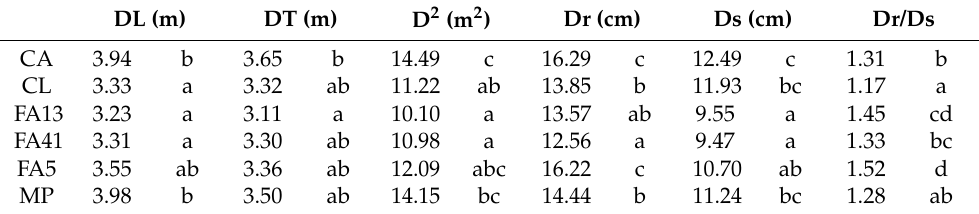
Mean values in the same column followed by different letters denote significant differences among rootstocks, based on Tukey’s test ( p < 0.05). CA: Carrizo citrange; CL: ‘Cleopatra’ mandarin; FA13: Forner-Alcaide no.13; FA41: Forner-Alcaide no.41; FA5: Forner-Alcaide no.5; MP: C. macrophylla Wester. The trunk diameter was negatively correlated with leaf Zn content (r = − 0.42; Table 2),